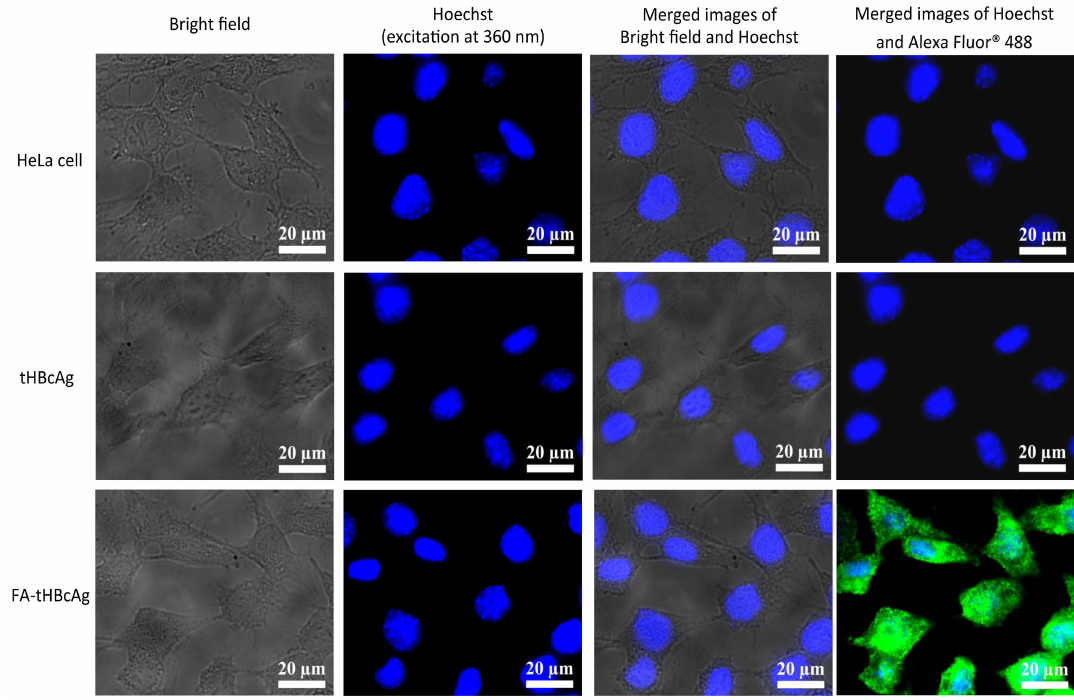
Figure 2. Translocation of tHBcAg VLNPs conjugated with folic acid into HeLa cells. The cancer cells were incubated with 25 µ g of tHBcAg VLNPs (tHBcAg), and folic acid (FA)-conjugated tHBcAg VLNPs (FA-tHBcAg). The internalised tHBcAg VLNPs were examined using an immuno-fluorescence microscope. Non-treated HeLa cells were used as a negative